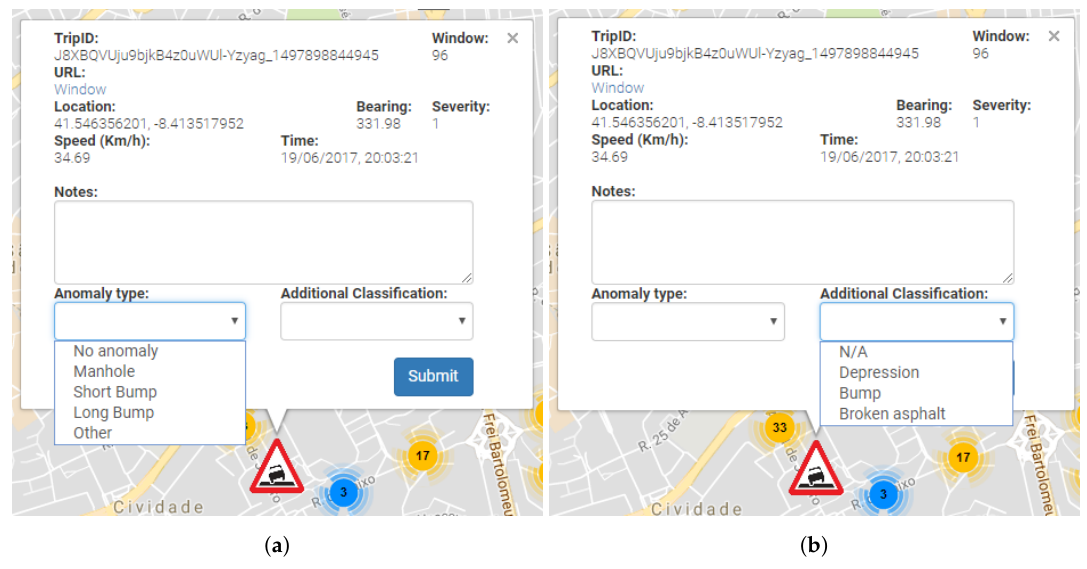
Figure 4. Anomaly validation: ( a ) anomaly type validation; and ( b ) additional anomaly information.